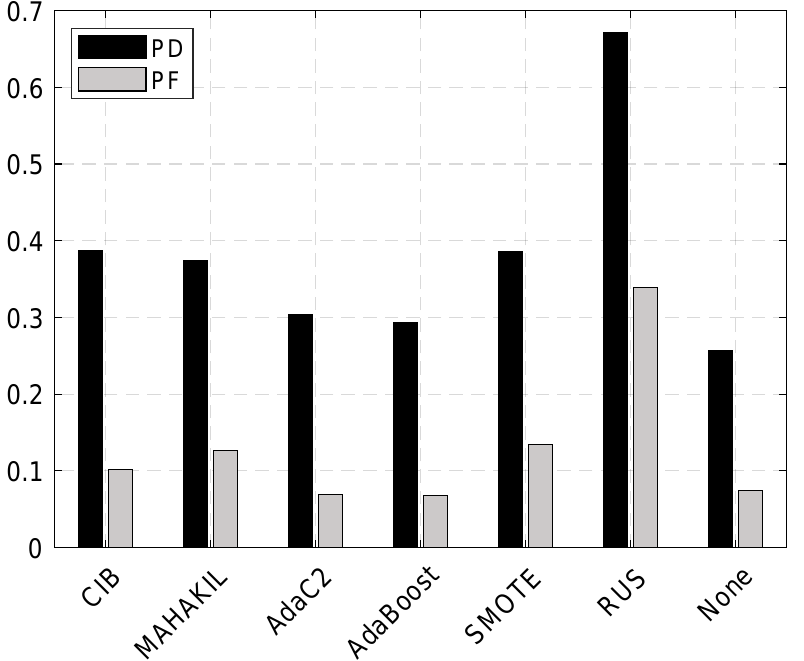
Figure 4. Barplots of PD and PF for all methods across all benchmark datasets. The horizontal line in the box denotes the median, while the asterisk indicates the